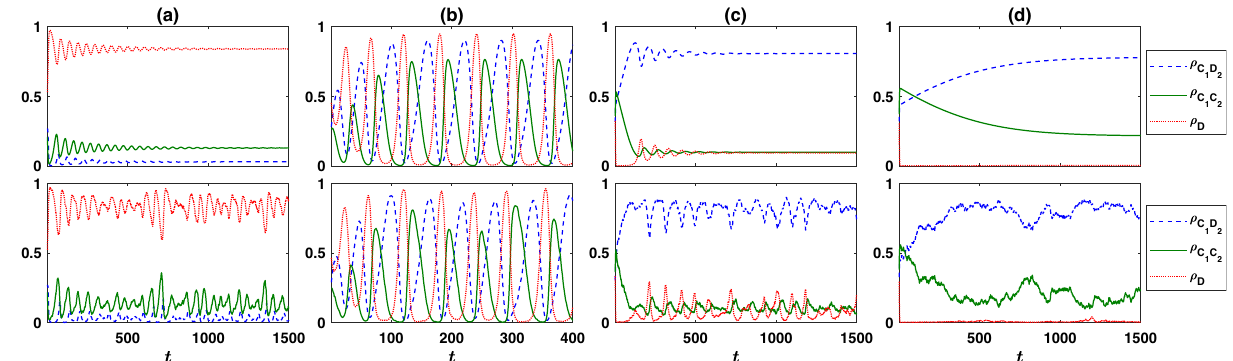
Figure 2. Time evolution of the reward dilemma model. The frequency of different strategies as a function of time is plotted. The top panels represent numerical solutions of the replicator dynamics, and the bottom panel results from a simulation in a population of N = 5000 individuals. In all the cases, r 1 = 1.8 . In ( a ), r 2 = 2 , which is slightly larger than the threshold necessary for the evolution of cooperation, 2 − r 1 / g = 1.82 , and thus a small fraction of C 1 C 2 strategies evolve. In ( b ) r 2 = 3.8 , corresponding to the cyclic phase where different strategies cyclically dominate the population. In ( c ) and ( d ), respectively, r 2 = 8.8 and r 2 = 9.8 , both corresponding to the cooperative fixed point. Parameter values: ν = 10 − 3 , g = 10 , c = 1 , and π 0 = 2 . The replicator dynamics is solved starting from homogeneous initial conditions, and simulations are performed starting from random assignment of